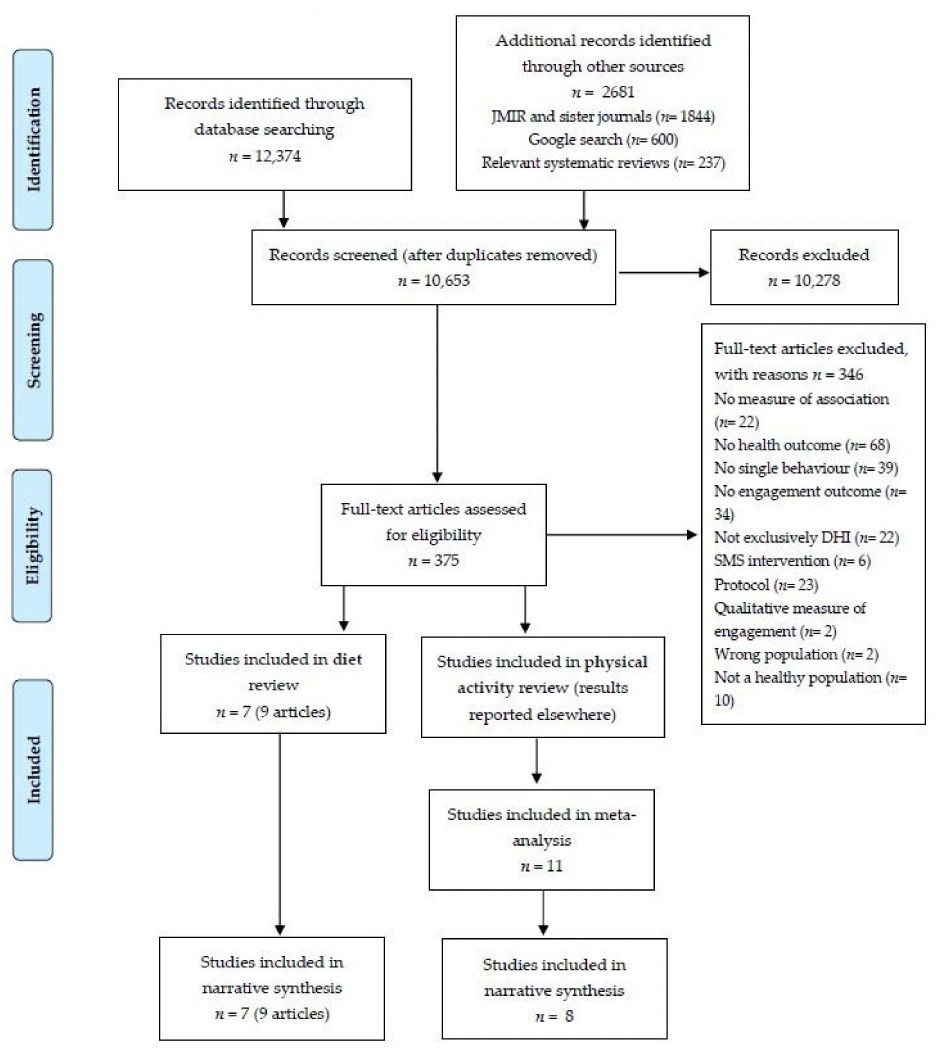
Figure 1. PRISMA flow diagram of included studies in the diet